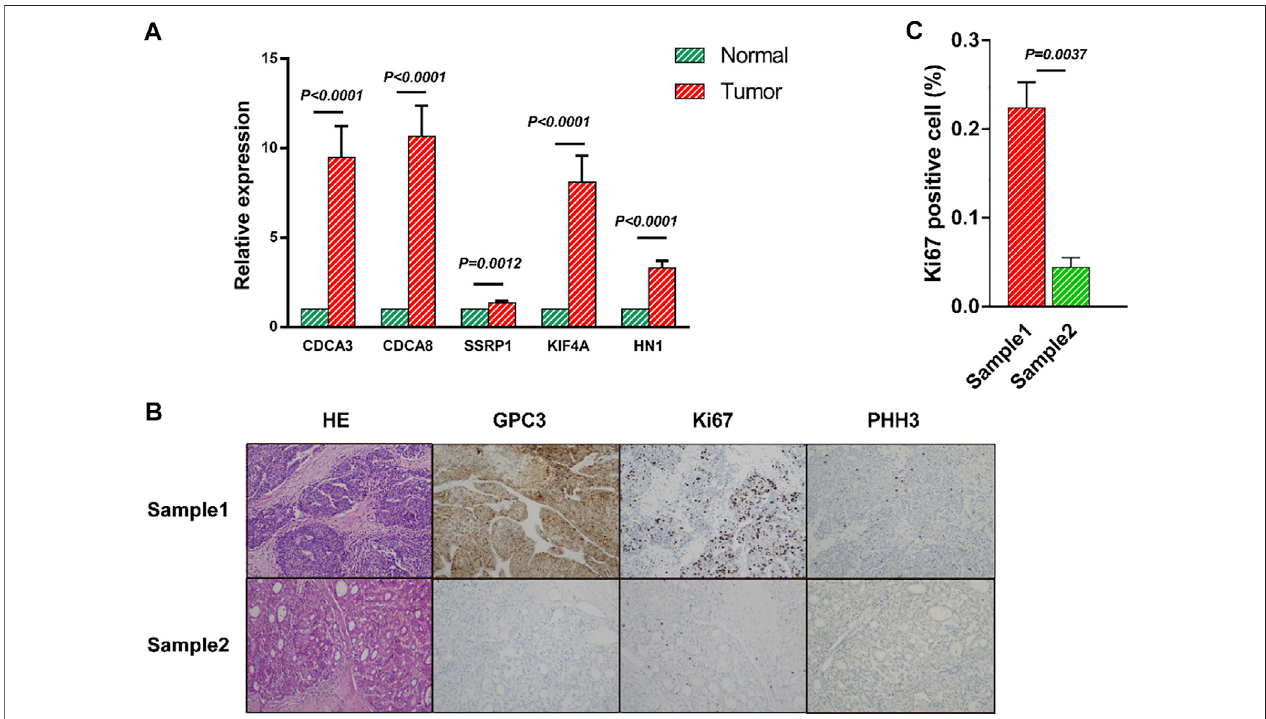
FIGURE 8 | Validation of the mRNA panel signature in HCC patients from clinical tissue specimens (A) The mRNA relative expression of CDCA3, CDCA8, SSRP1, KIF4A and HN1 in HCC tissues was evaluated by qRT-PCR. (B) Representative hematoxylin-eosin (H&E) and immunohistochemistry (IHC) staining of GPC3, Ki67 and PHH3 in HCC patients. (C) There was signi fi cant difference between the Sample1 and Sample2 by Ki67 expression. All data are shown as the mean ±